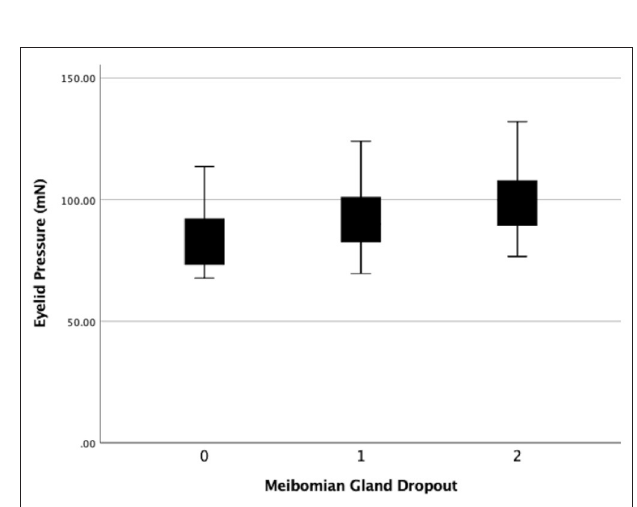
FIGURE 6 | The relationship between the eyelid pressure and the corneal fluorescein staining score (CFS) (r = 0.528, P = 0.000).